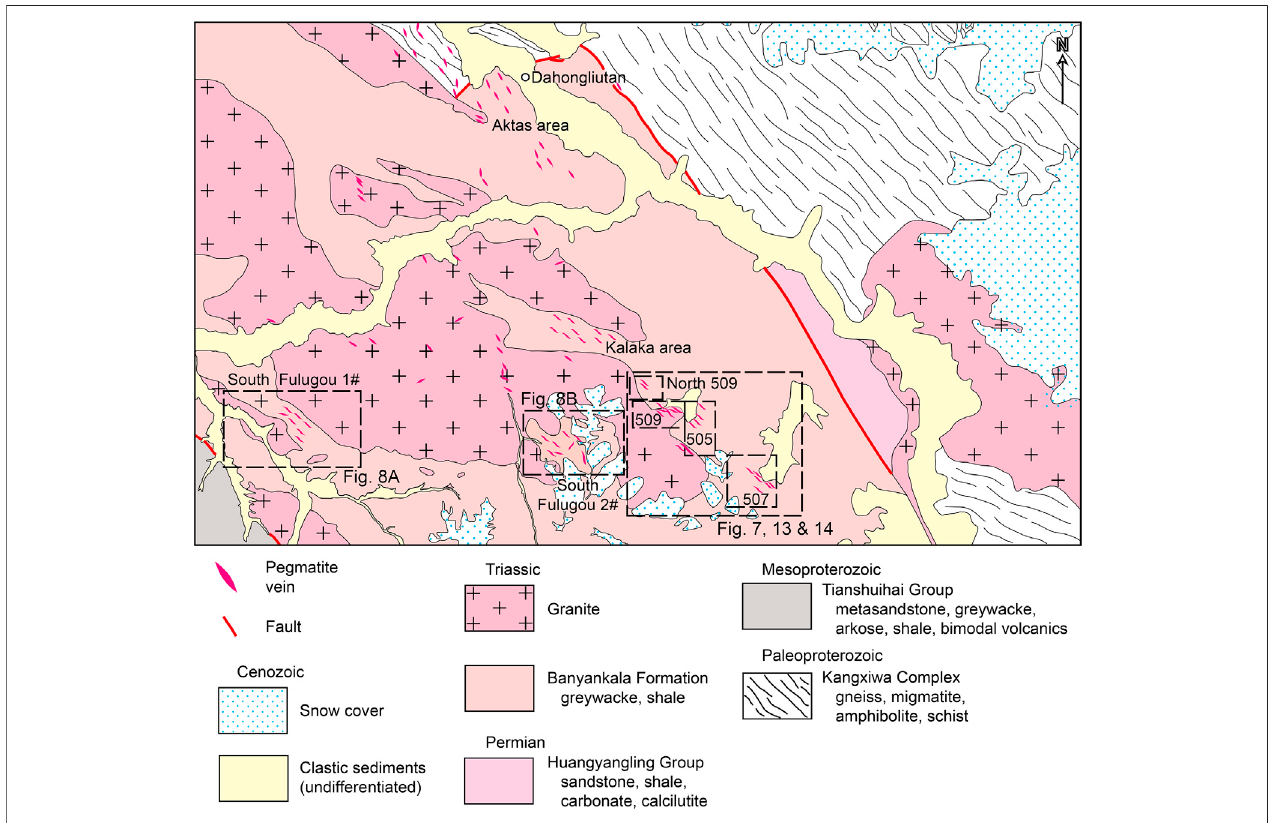
FIGURE 6 | Geological map of the Dahongliutan